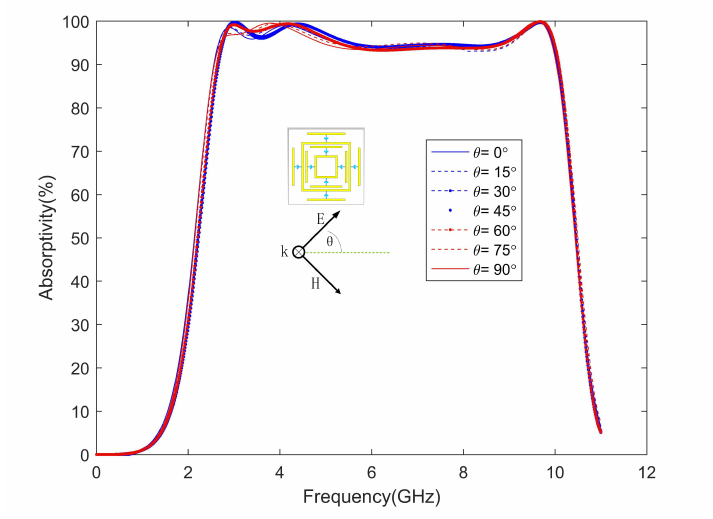
Figure 5. Simulated absorptivity for different polarization angles.